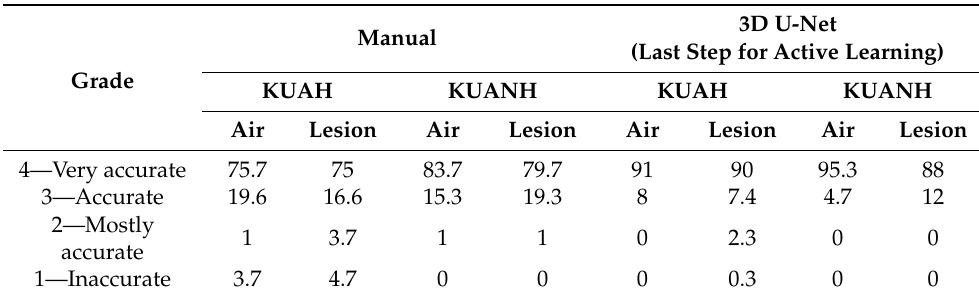
Table 5. Qualitative results from visual scoring of automatic maxillary sinus segmentation on CBCT from 100 Randomly Selected slices (internal-KUAH and external-KUANH)